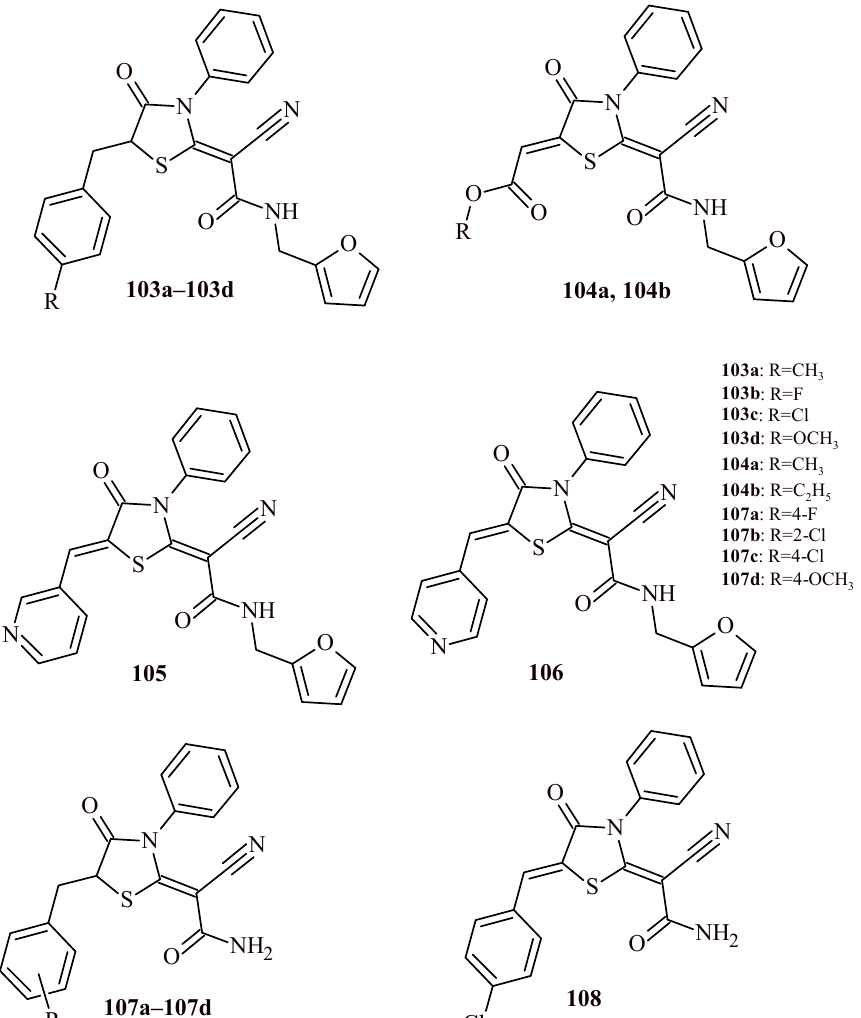
Figure 45. The structures of 4-oxothiazolidin-2-ylidene derivatives with potential antimicrobial activity. In the paper published by Kumar et al. [20], antimicrobial activity of 5-arylidenethiazolidine- 2,4-dione derivatives ( 5a – 5s and 6 ) was discussed (Figure 2). Synthesized TZD derivatives were evaluated for their in vitro antimicrobial activity by serial tube dilution procedure. The antibac- terial screening results were found to be comparable with cefadroxil, a standard drug used in bacterial infections and exceeded fluconazole in terms of antifungal activity. The screening revealed that Compounds 5l and 5d were moderately active against S. aureus (MIC of 17.9 µ M and 18.2 µ M, respectively). Compounds 5o and 5i were moderately active against Bacillus sub- tilis (MIC of 18.5 µ M and 18.6 µ M, respectively), Compounds 5l and 5h were effective against K. pneumoniae (MIC = 17.9 and 18.6 µ M, respectively). Compound 5n (MIC = 18.5 µ M) and Com- pound 5h (MIC = 18.6 µ M) exhibited promising activity against Salmonella typhi . The antifungal screening results revealed that the Compounds 5l (MIC = 17.9 µ M) and 5n (MIC = 18.5 µ M) had good activity against C. albicans and Aspergillus niger . The most active derivative against C. albicans was 5k (MIC = 16.1 µ